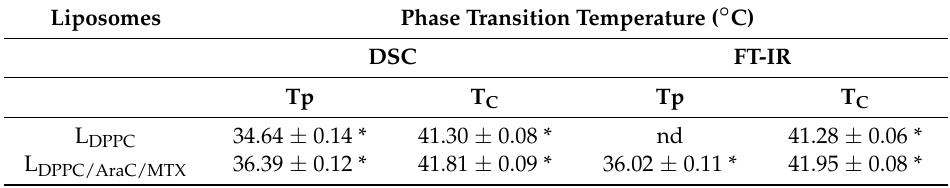
Table 1. Pre-transition temperature (Tp) and main transition temperature (T C ) determined for L DPPC and L DPPC/AraC/MTX liposomes by DSC and FT-IR